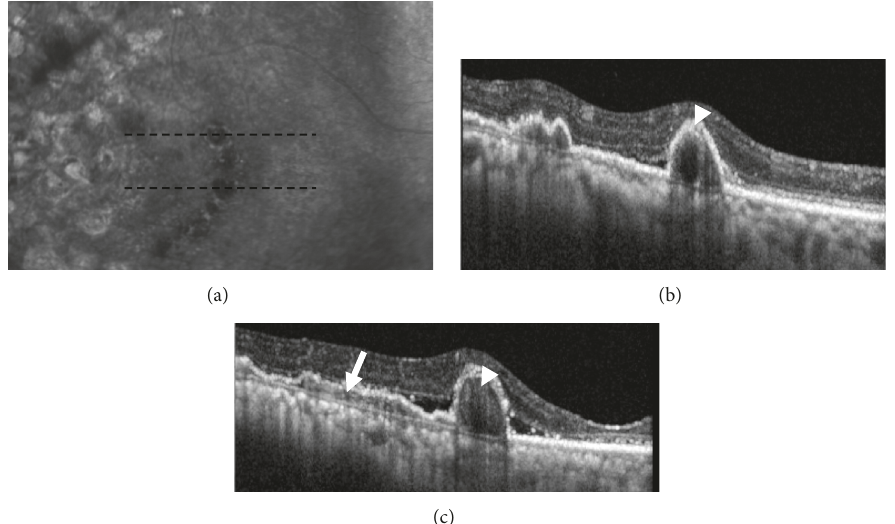
Figure 5: Infra-red image (a) of right eye with corresponding enhanced depth-imaging (EDI) spectral domain-OCT of right macula at the 9 months follow-up time-point. The black dashed line indicates to relevant position of the EDI images (upper b, lower c). Note the “double- layer” sign in image (c) (white arrow) as a hyper-reflective area in the space between the retinal pigment epithelium and Bruch’s membrane. This suggests the location of the branching vascular network. Within the pigment epithelial detachments, hyper-reflective lesions can be seen that most likely represent polyps (white arrow-head in b, c).